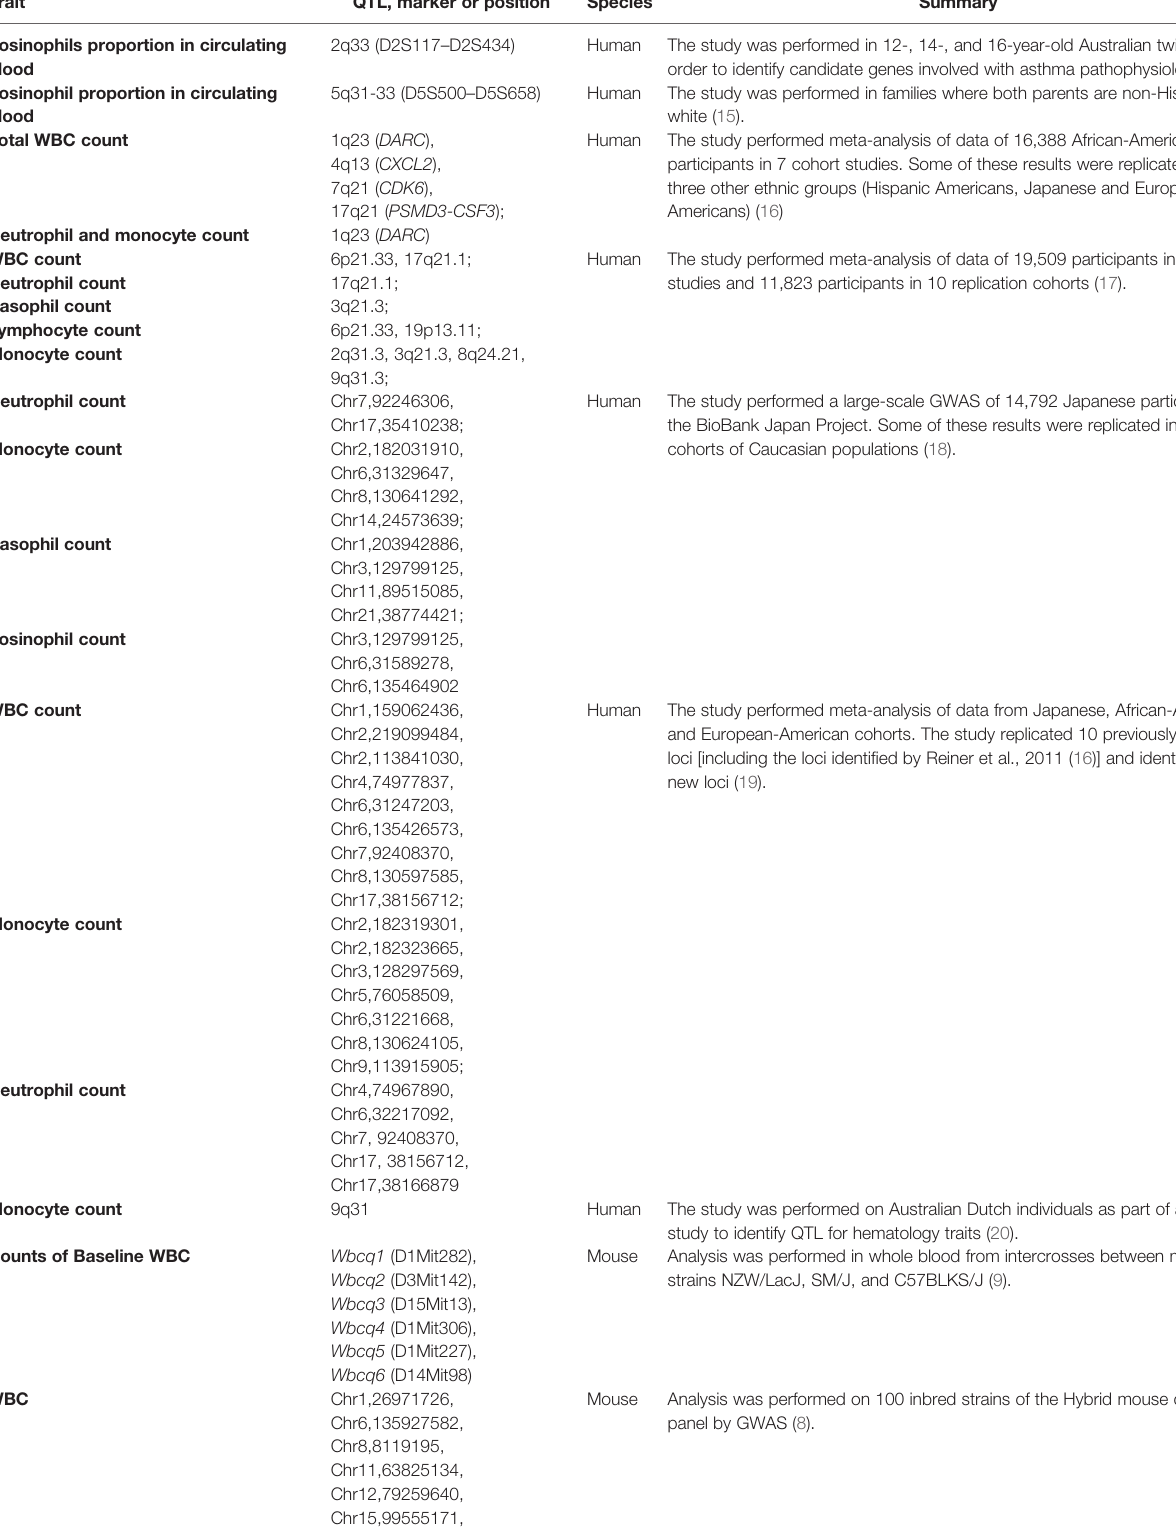
TABLE 1 | QTLs controlling circulating WBC levels in human, mice and